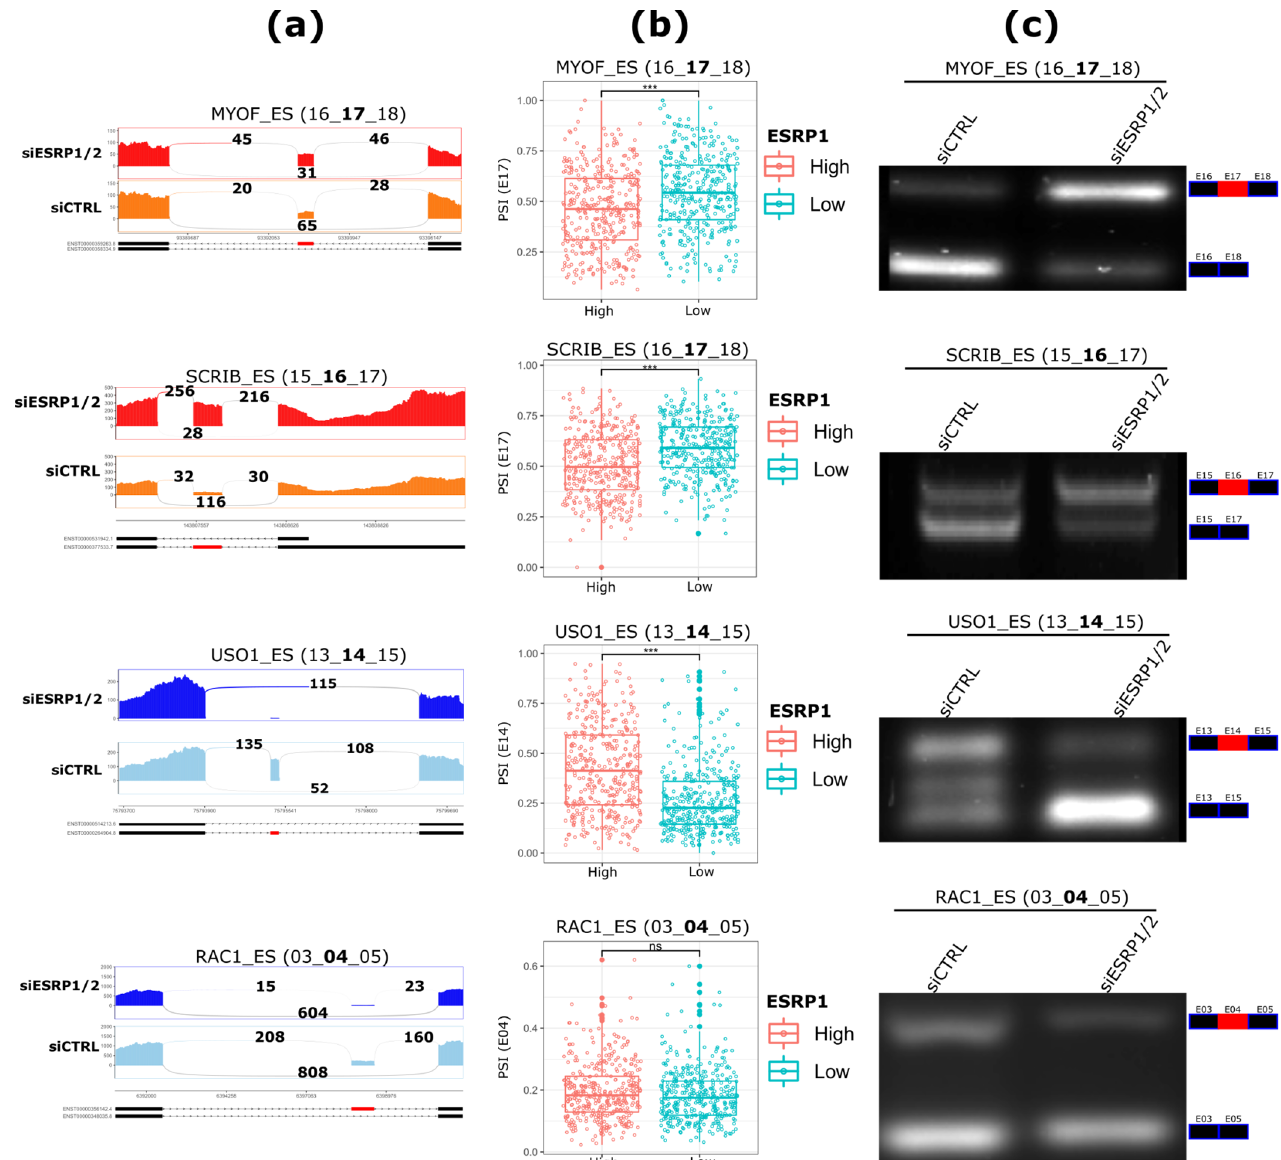
Figure 3. ASEs validation by RT-PCR analysis. ( a ), Sashimiplots reporting the read coverage over the regulated exons and their flanking junctions, as identified by rMATS. The total number of normalized read counts supporting each exon–exon junction is reported. ( b ) The inclusion levels (PSIs) of the validated exons in ER+ BCs partitioned based on ESRP1 median mRNA levels into high- and low-expressing samples. ( c ), RT-PCR products were analyzed using agarose gel electrophoresis. The upper and lower bands represent the inclusion and exclusion forms of the events, respectively. Representative pictures out of three biological replicates. The complete gel image of ( c ) is reported as Supplementary Materials Figure S5. *** Wilcoxon test p -value < 0.001; ns: non significant.